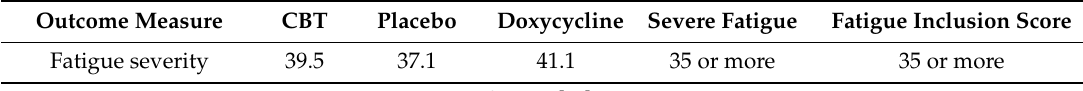
Table 2. Mean fatigue severity scores at